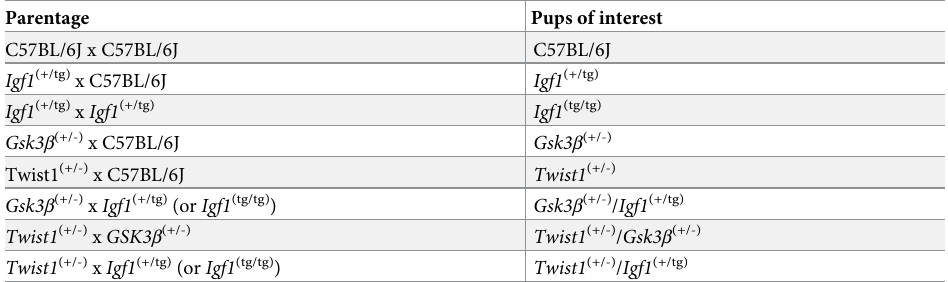
Table 1. Genotypes of mouse crosses performed and subsequent pups of